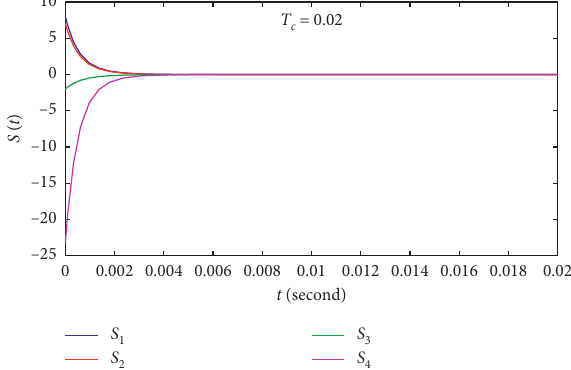
Figure 12: Time response of sliding mode surface switching function S ( t ) with T c � 0 . 02.